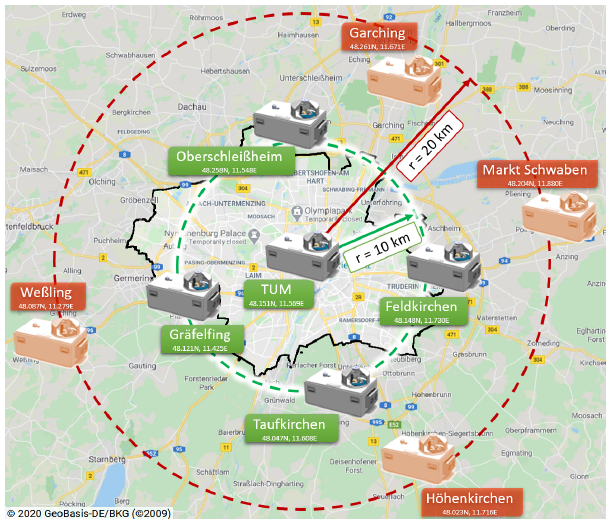
Figure 8. Map of the greater Munich area together with the two different sensor network setups that have been implemented. The urban area itself (indicated by the black border) is largely contained within the inner green dashed circle in the center, which represents the current setup of the stationary network. The light red shaded sensor systems, together with the center station, represent the setup during our 2018 summer campaign. Both setups are characterized by a center station and a station in each compass direction to mea- sure the inflow and outflow of GHG concentrations under arbitrary wind conditions. Map data are from © Google Maps.